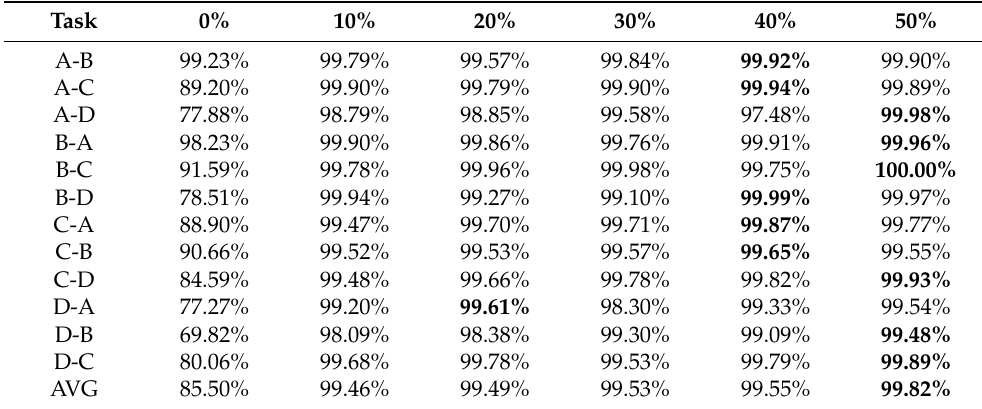
Table 6. Experimental results for different proportions of the target domain data. The numbers in bold indicate the highest classification accuracy in corresponding task.